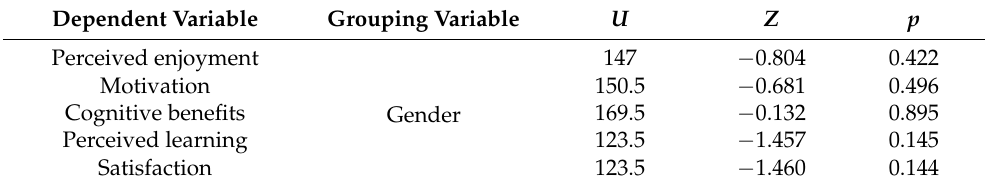
Table 4. Correlations between participants’ gender, prior experience, and performance in the VRER experience. Dependent Variable Independent Variable Spearman’s rho p Familiarity with VR 0.016 0.921 Escape Room completion 0.171 0.280 Completion time − 0.096 0.547 Gender Experienced difficulties 0.079 0.621 Scaffolding of challenges − 0.118 0.457